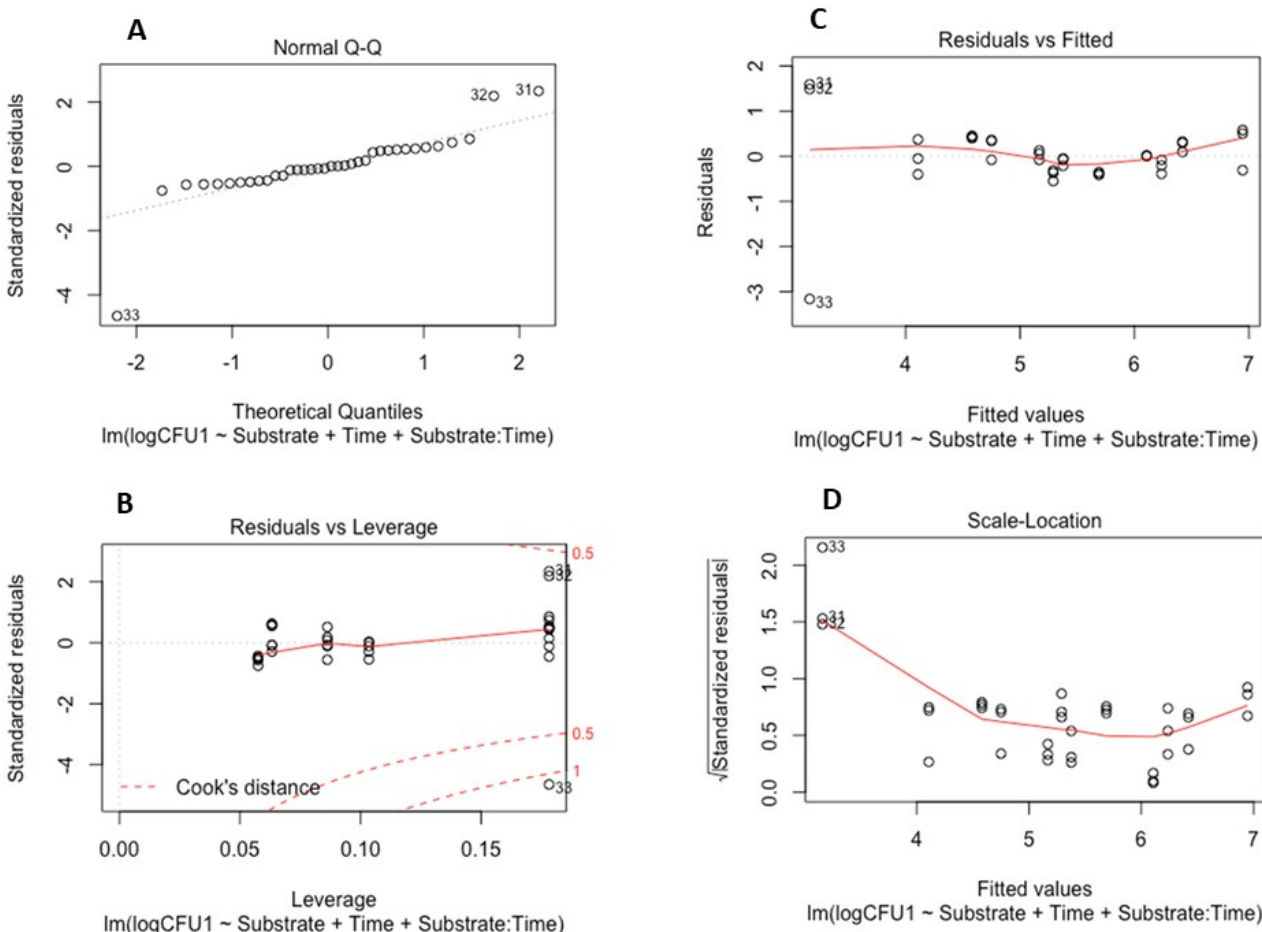
Figure 4. Model validation for survival of Phytophthora cactorum : ( A ) Q-Q plot of standardized residuals against fitted values of the model; ( B ) residuals versus leverage values; ( C ) residuals versus fitted values plot; ( D ) scale location of residual values plot.